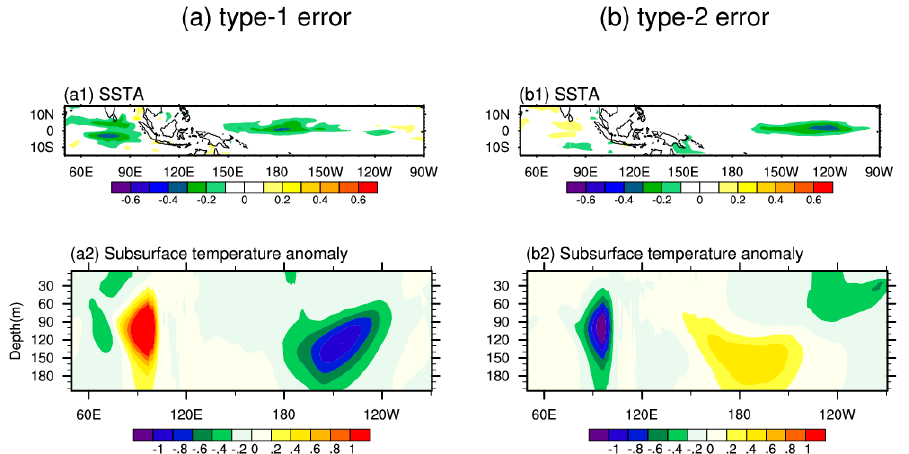
Figure 3. Spatial patterns of the ( a ) type-1 and ( b ) type-2 initial errors that are most likely to induce a significant SPB for pIOD predictions. The upper and lower panels show the surface and the equatorial subsurface component (units: °C, averaged over the region 5° S–5° N).